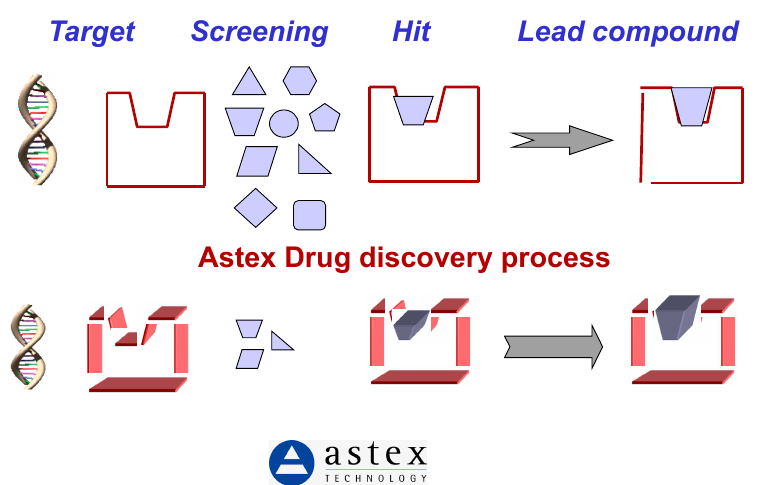
Figure 6. The evolution of structure-guided drug discovery. A schematic comparison of the conventional drug discovery process with very large libraries of drug-like compounds of molecular weight ~500 daltons, compared with the Astex fragment-based structure-guided approach in which libraries < 1000 compounds of molecular weight < 300 daltons are screened using biophysical methods defining structures and a ffi nities, before being elaborated to drug-like compounds with nano-molar a ffi nities [69,70].